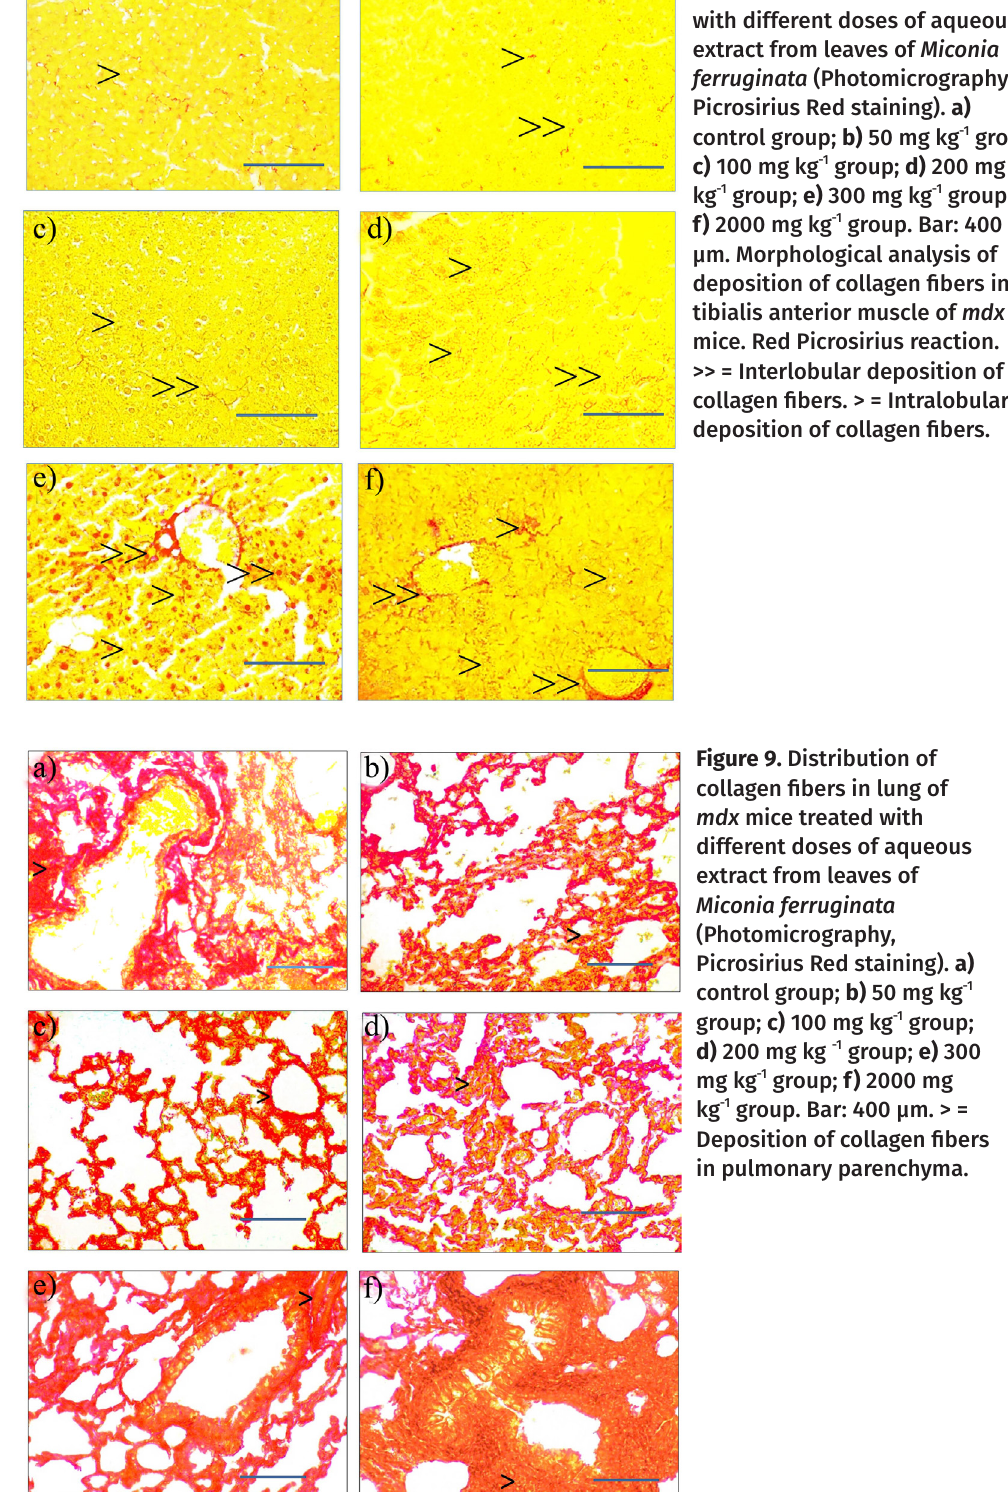
Figure 8. Distribution of collagen fibers in liver of mdx mice treated with different doses of aqueous extract from leaves of Miconia ferruginata (Photomicrography, Picrosirius Red staining). a) control group; b) 50 mg kg -1 group; c) 100 mg kg -1 group; d) 200 mg kg -1 group; e) 300 mg kg -1 group; f) 2000 mg kg -1 group. Bar: 400 µm. Morphological analysis of deposition of collagen fibers in tibialis anterior muscle of mdx mice. Red Picrosirius reaction. >> = Interlobular deposition of collagen fibers. > = Intralobular deposition of collagen